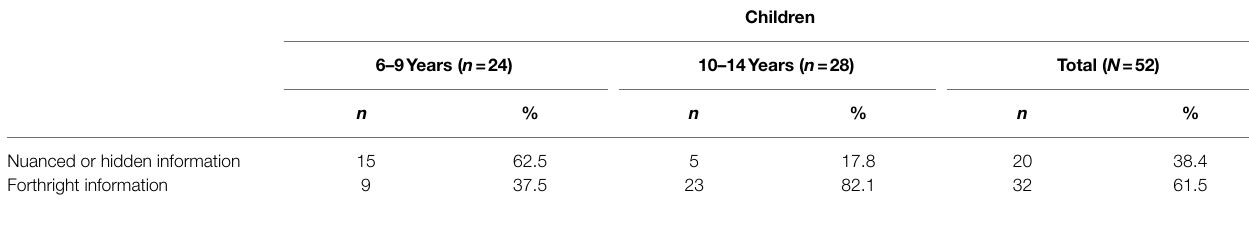
TABLE 6 | Communication of illness from mothers to children depending on age-group.